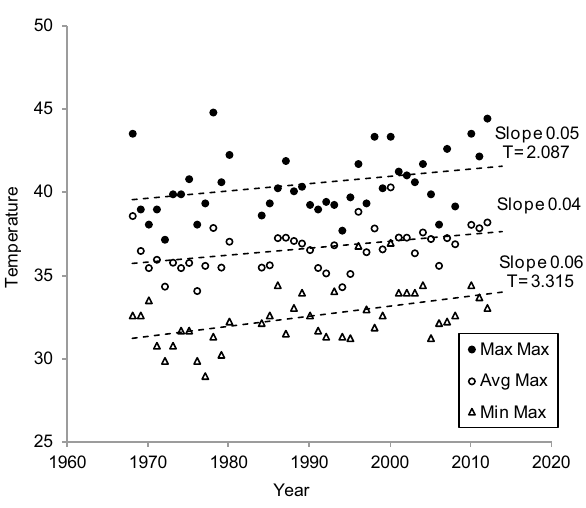
Fig. 3 Monthly maximum temperature in July Azraq